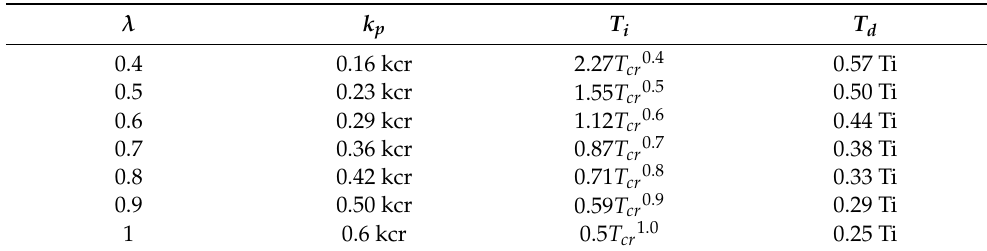
Table 1. FO-PID parameters according to the modified Ziegler-Nichols method and for different values of the fractional order λ